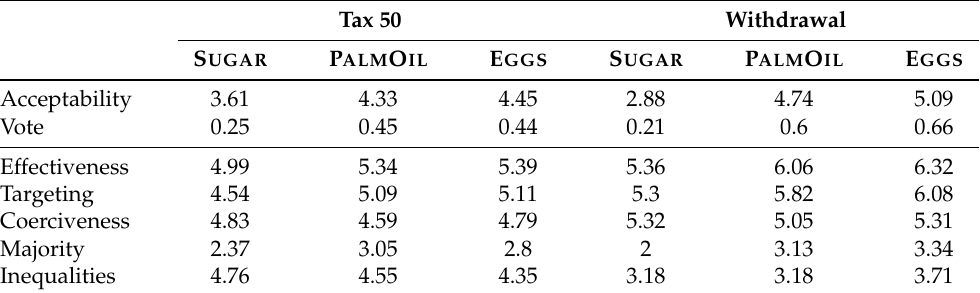
Table A2. Summary statistics of tax50 and withdrawal